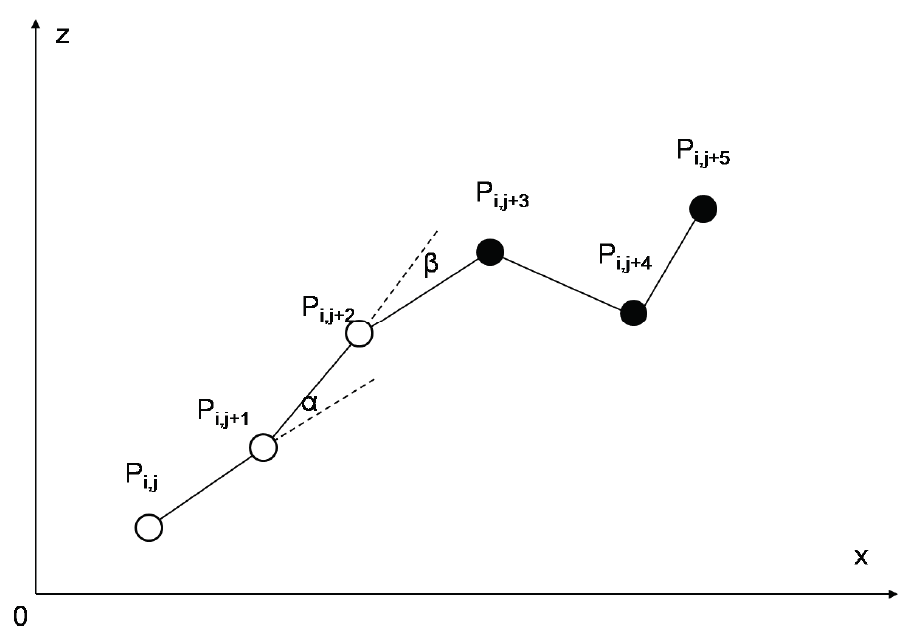
Figure 2. Points of smooth and rough areas (the white and black points represent the points of smooth and rough areas,